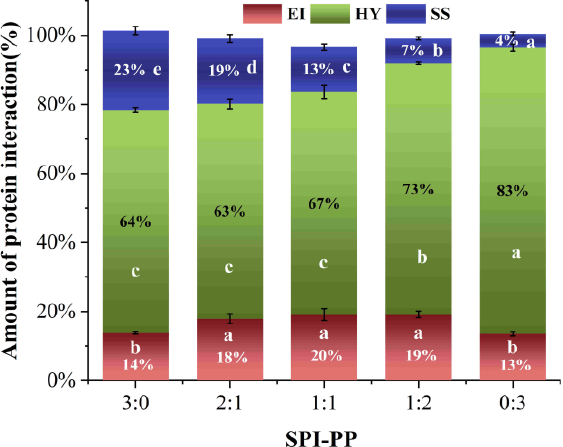
Figure 7. Molecular interaction force analysis of composite gels at different SPI and PP ratios ( EI: electrostatic interaction and hydrogen bond; HY: hydrophobic interaction; SS: disulfide bond.). Different lowercase letters in the figure indicate significant differences between samples in the same group ( p < 0.05).